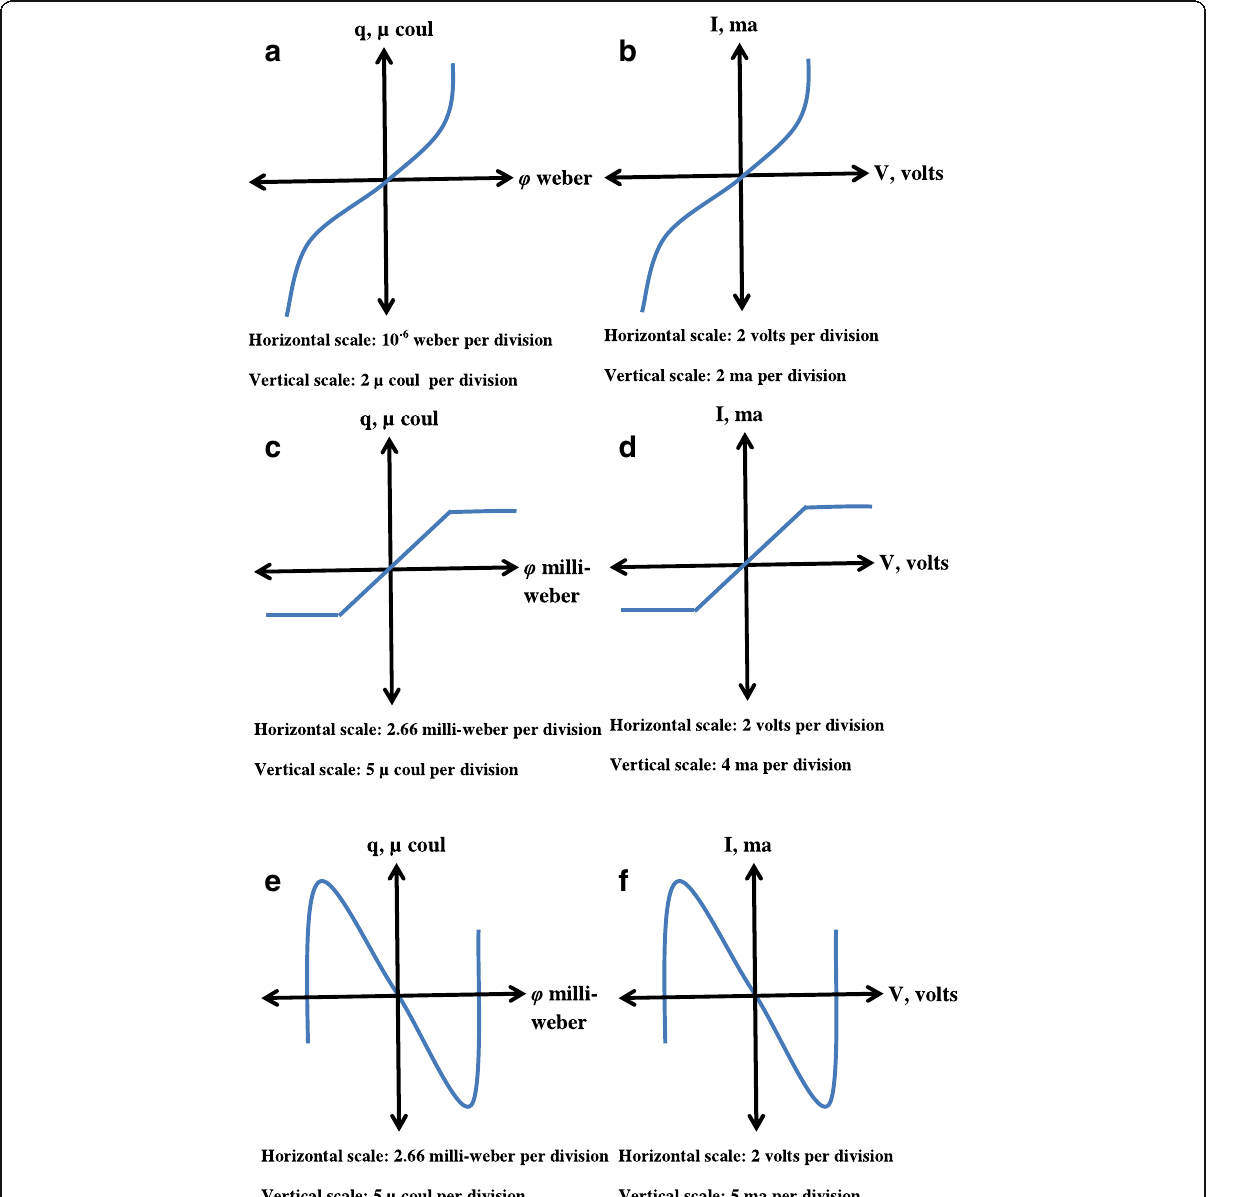
Fig. 1 a – f Flux-charge ( ϕ - q ) curves obtained from three different memristors